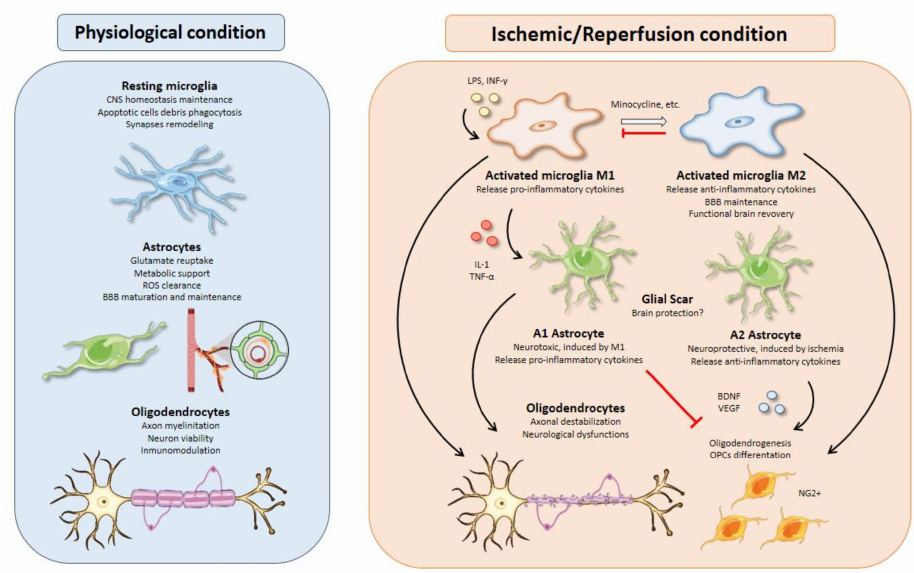
Figure 2. Glial cell functions, responses, and interactions in physiological and I/R conditions. Microglial activation is one of the earliest events after brain ischemia. The inflammatory landscape generated in the ischemic brain by inflammatory cytokines, debris, or molecules released from dead cells triggers microglia activation. Activated microglia are typically divided into M1 and M2 phenotypes. M1 microglia present a pro-inflammatory profile releasing cytokines such as IL-1 or TNF- α that can polarize astrocytes toward a neurotoxic phenotype, aggravating the inflammatory response. On the other hand, M2-microglia release anti-inflammatory cytokines, sustain blood brain barrier (BBB) integrity, and stimulate oligodendrogenesis through oligodendrocyte progenitor cells’ (OPCs) differentiation into NG2 + cells, thus promoting functional recovery after brain ischemia. All therapeutic strategies based on microglia are focused on minimizing the effects of M1-microglia using drugs like minocycline to switch phenotype from M1 to M2. Besides, M2 microglia could promote an inhibition of M1 microglia. Activated astrocytes are usually classified into A1 and A2 phenotypes. In line with M1 microglia, A1 astrocytes present a neurotoxic profile releasing pro-inflammatory cytokines with inhibitory effects over oligodendrogenesis and OPCs’ differentiation. In contrast, A2 astrocytes have neuroprotective functions releasing anti-inflammatory cytokines and trophic factors, such as BDNF or VEGF with similar effects over oligodendrocytes as those of M2 microglia. Oligodendrocytes are especially sensitive to oxidative stress and excitotoxicity generated during brain ischemia. Demyelination affects neurons owing to axonal destabilization, generating